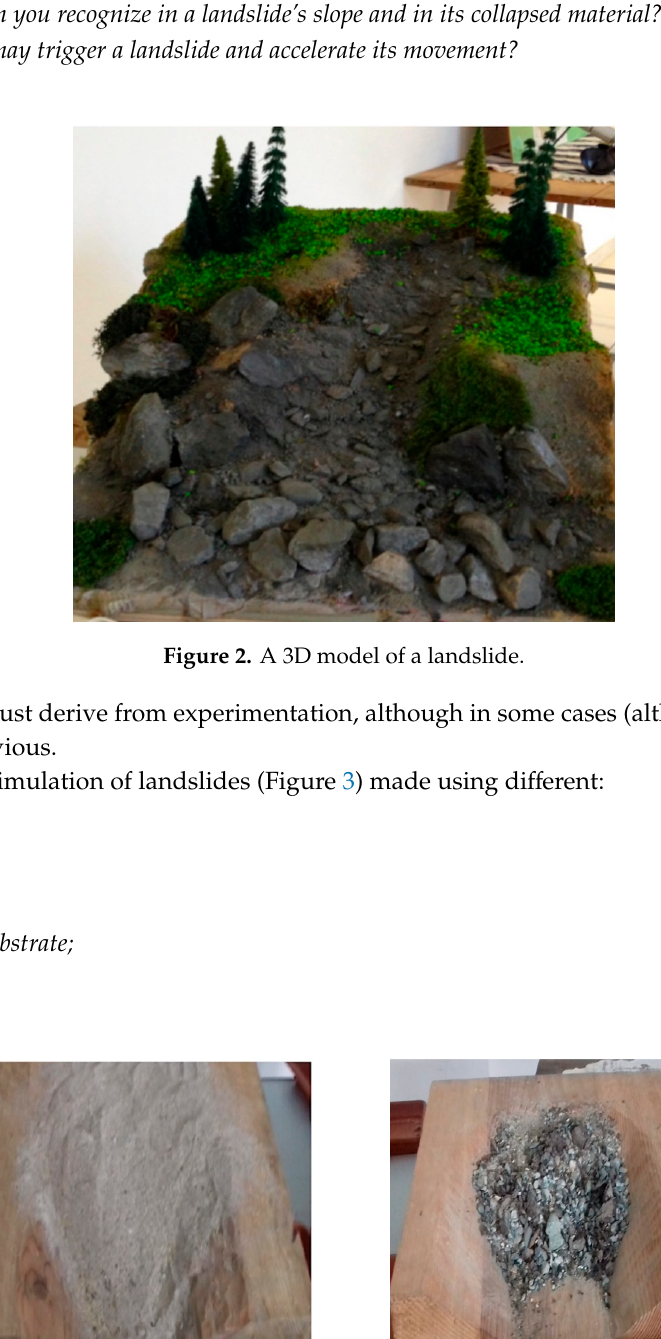
Figure 3. Preparation of a landslide model with different materials (sand or gravel).